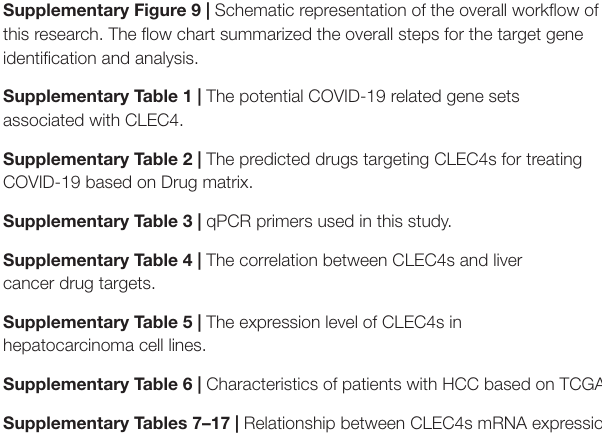
Supplementary Figure 7 | The correlation between CLEC4s and liver cancer drug targets at mRNA level. ASGR1(CLEC4H1), ASGR2(CLEC4H2), FCER2(CLEC4J), CD207(CLEC4K), CD209(CLEC4L), VEGFR1/2/ 3(FLT1/KDR/FLT4), PDGFR- α / β (PDGFRA/PDGFRB). ∗ p < 0.05; ∗∗ p < 0.01; ns, not significant. Supplementary Figure 8 | Analysis of CLEC4 expression in liver cancer cell lines.